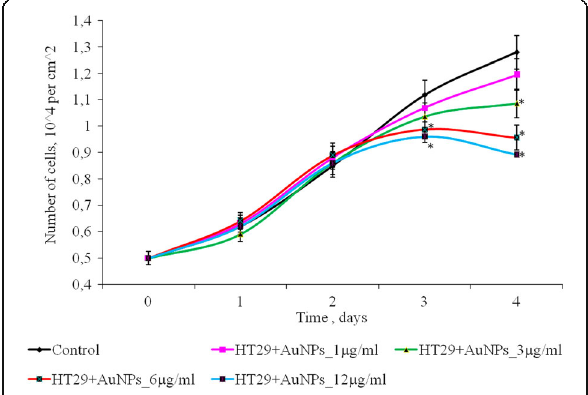
Fig. 5 Proliferation of HT29 cells after exposure of AuNPs, * p ≤ 0.05 is significant versus with the